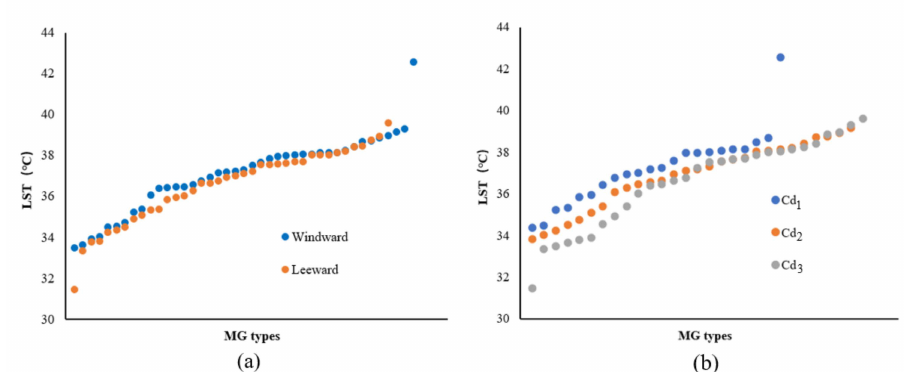
Figure 21. ( a ) Scatter plot of LST values corresponding to the MG types of green space in different locations (leeward or windward) in the Width-IV river zone according to the increasing LST. ( b ) LST values corresponding to the MG types of the green space with different Cd grades in the Width-IV river zone according to the increasing LST.